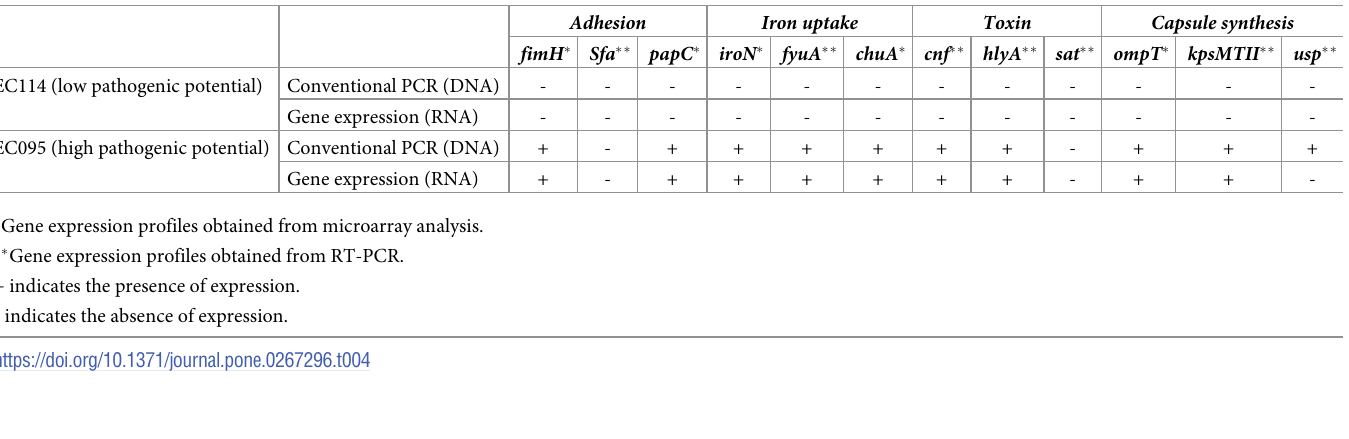
Table 4. Summary of the gene expression profile of two selected ASB